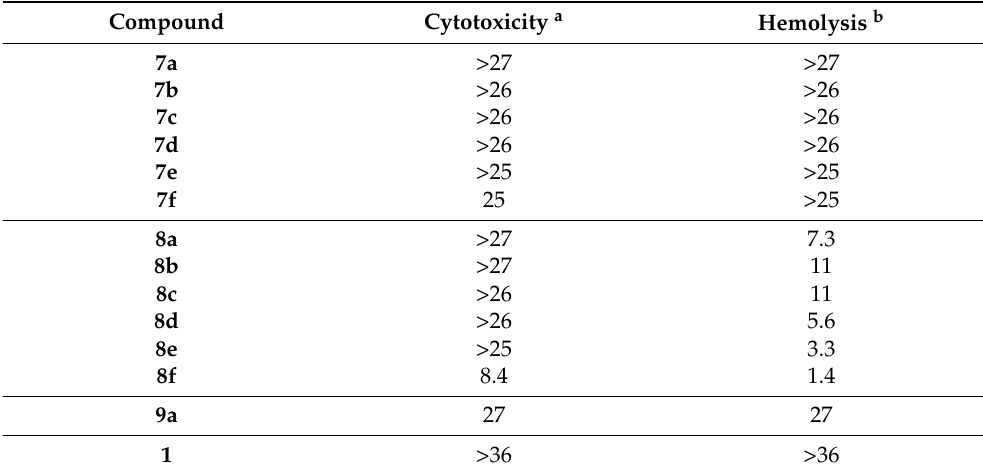
Table 2. Cytotoxicity (IC 50 , µ M) and hemolytic (HC 10 , µ M) activities of compounds 7 – 9 and squalamine ( 1 ). Compound